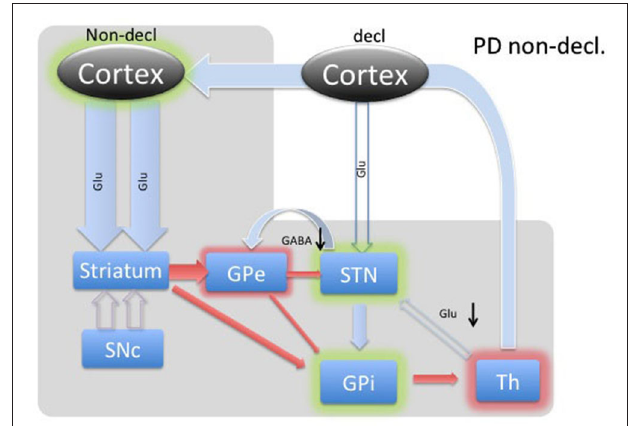
FIGURE 3 | Diagram of cortical and BG activity during an implicit memory task in a healthy control. The expected changes in STN are the increased concentration of GABA and the decreased concentration of glutamate. The thickness of arrows represents the theoretical expected concentration change relative to the baseline depicted in Figure 1 . The gray-shaded area represents the part of the BG circuitry involved in implicit memory task. Green shadows represent activation and red shadows represent suppression of activity in the structure.